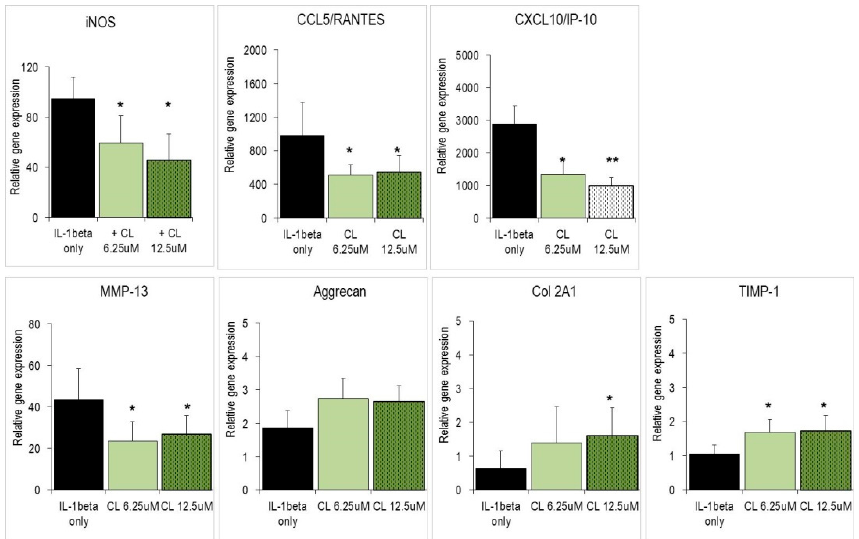
Figure 3 . Effect of substances on IL-1 β activated chondrosarcoma SW1353 cells. Cells were stimulated with IL-1 β for 4 h in the presence of indicated substances. Gene expression was determined